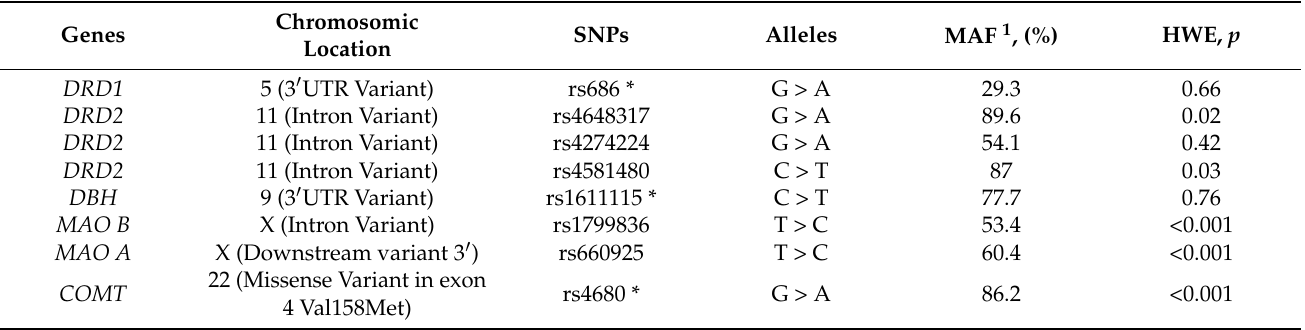
Table 1. The Hardy–Weinberg equilibrium (HWE) p -values and distribution of genotype frequencies of selected single-nucleotide polymorphisms